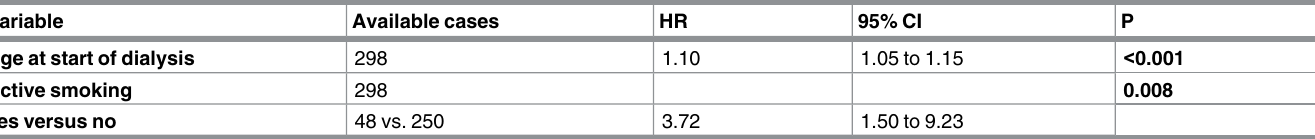
Table 6. Multivariable analysis for overall survival.